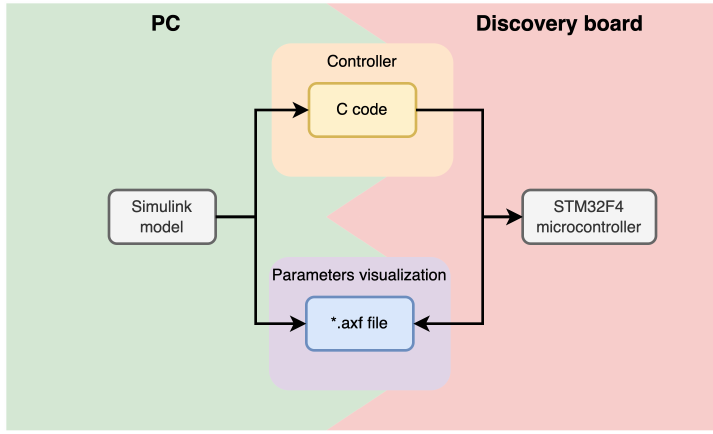
Figure 14. Data flow between the components of the